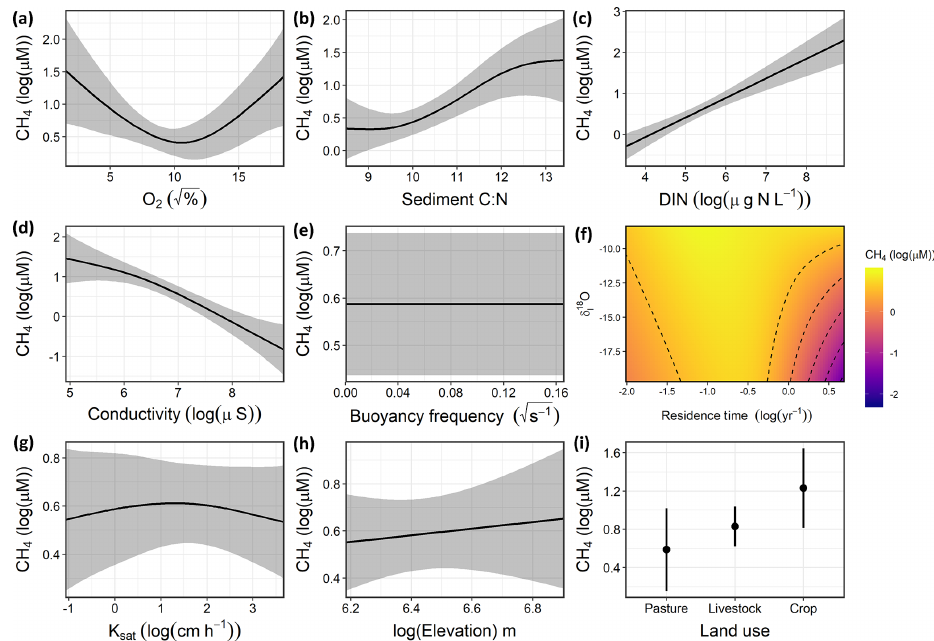
Figure 4. Response patterns of farm reservoir CH 4 concentrations with abiotic, biotic, hydromorphological, and landscape variables based on generalized additive models (GAMs). CH 4 was explained by a combination of (a) DO saturation, (b) sediment C / N, (c) DIN, (d) conductivity, (e) buoyancy frequency (not significant), ( f ) interaction between δ I and WRT, (g) soil K sat (not significant), (h) elevation (not significant), and (i) local land use. Model deviance explained was 74.1%. The response patterns shown are the partial effect splines from the GAM (solid line), and the shaded area indicates 95% credible intervals. See Table S5 and Fig. S3 for summary of model statistics and model fit with observed